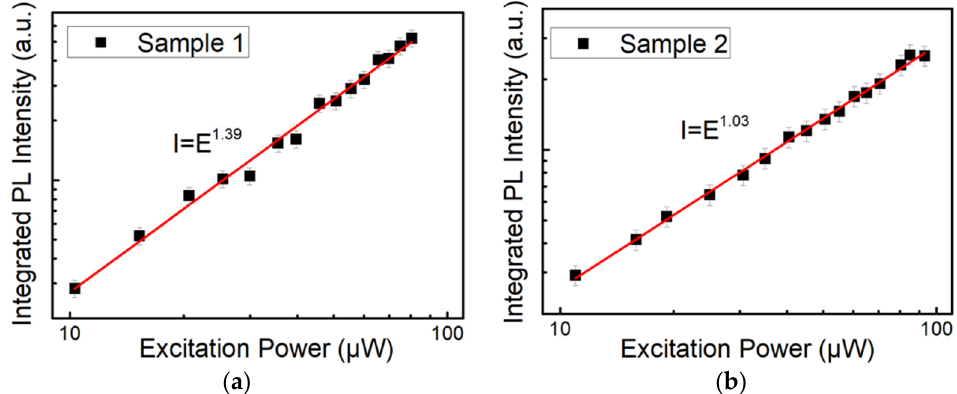
Figure 5. Integrated PL intensities for the ( a ) Sample 1 and ( b ) Sample 2 as functions of excitation power. Error bar is calculated standard error.